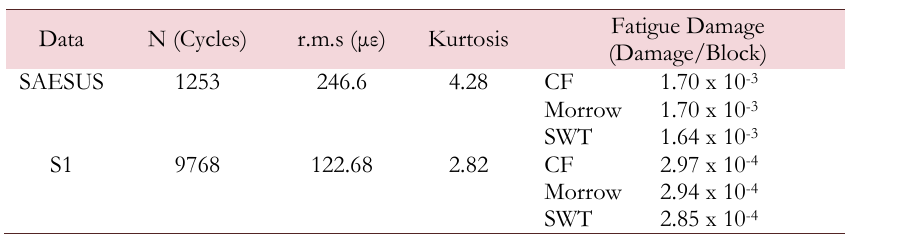
Table 1: Summary of statistical characteristic of the signals